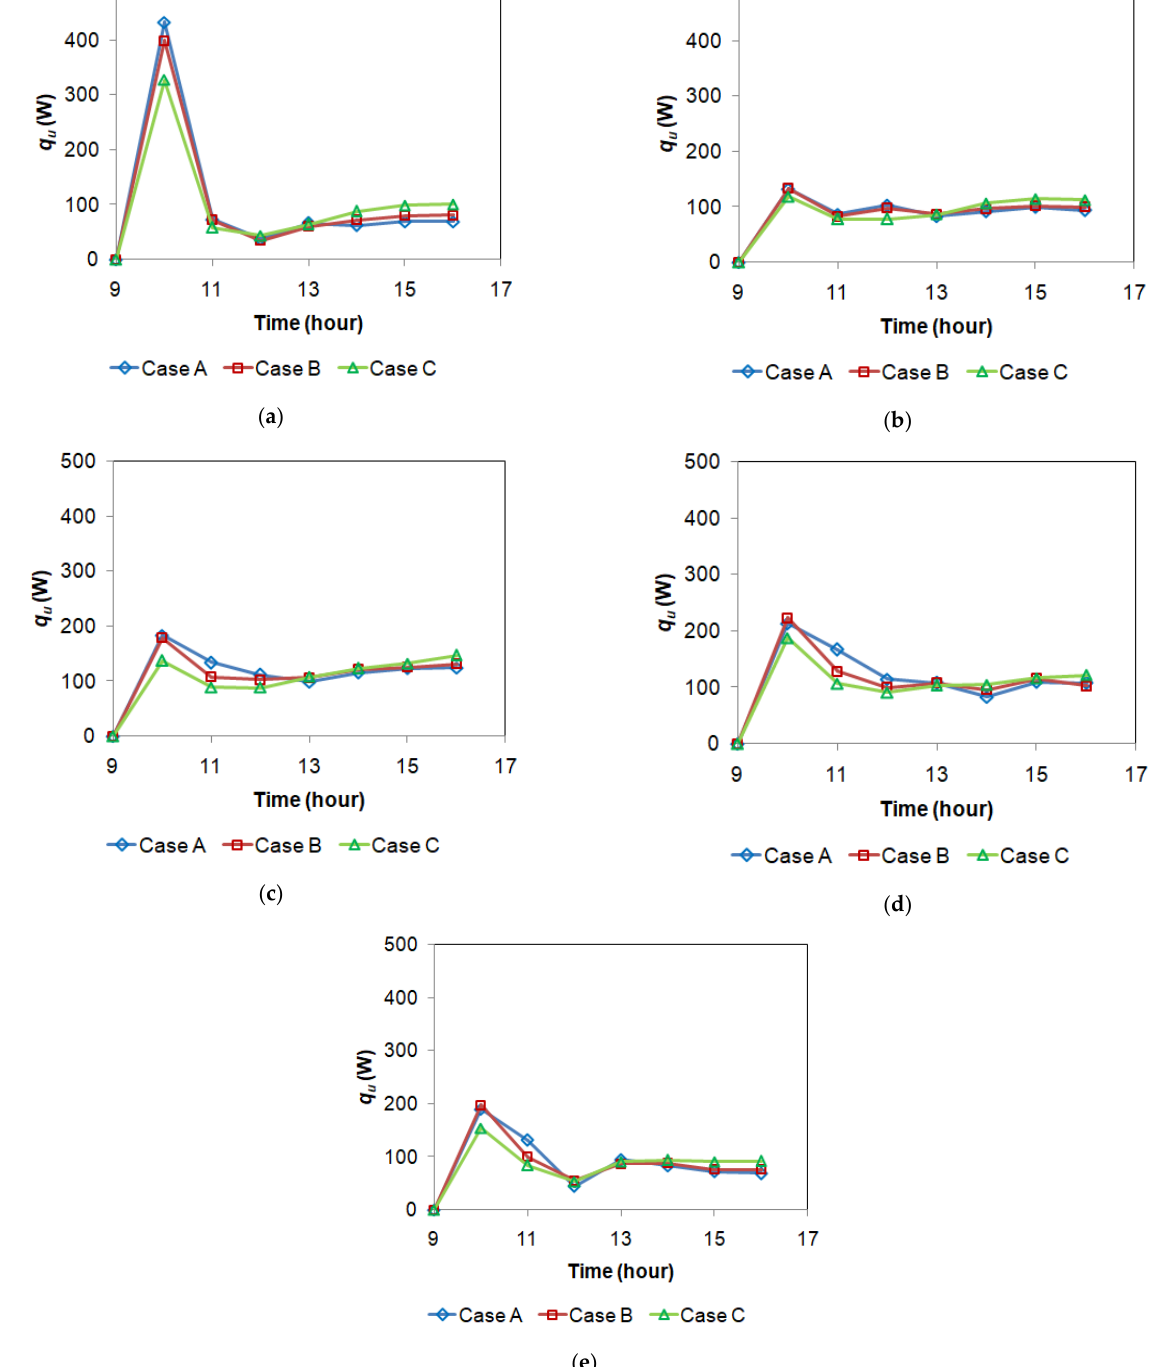
Figure 7. Relationship between useful heat and observation time for five days: ( a ) Day 1, ( b ) Day 2, ( c ) Day 3, ( d ) Day 4, and ( e ) Day 5.